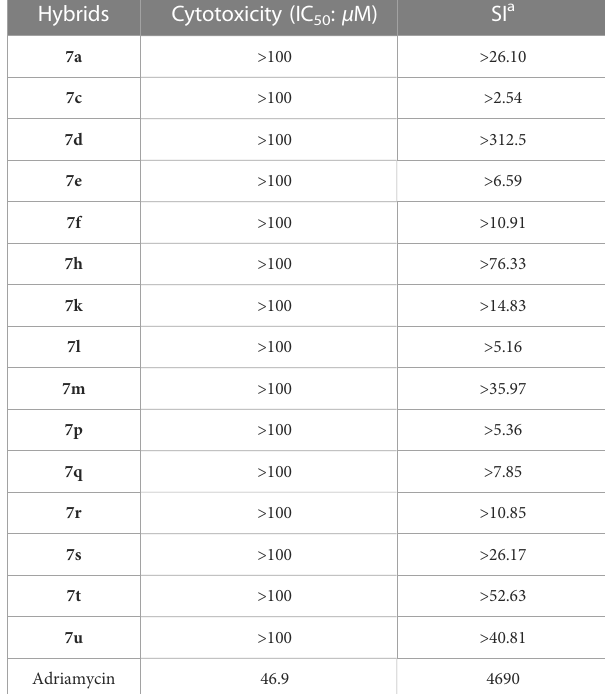
TABLE 3 The cytotoxicity, and selectivity index values of selected hybrids. Hybrids Cytotoxicity (IC 50 : µ M)